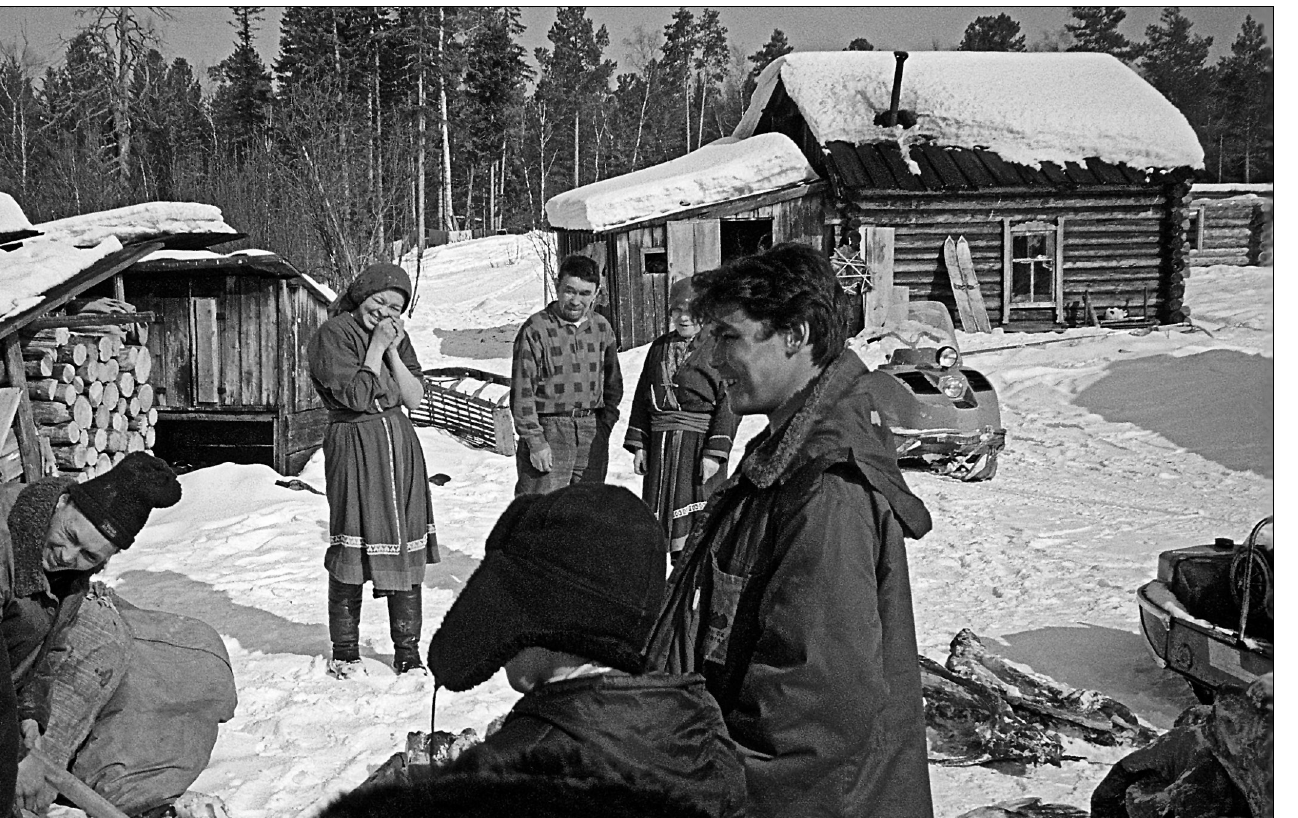
Figure 2 A riverside base camp or yurt, composed of the log cabins and storage huts of six Khanty households; the people are watching an elk being butchered by the man at the lower left, March 1999.